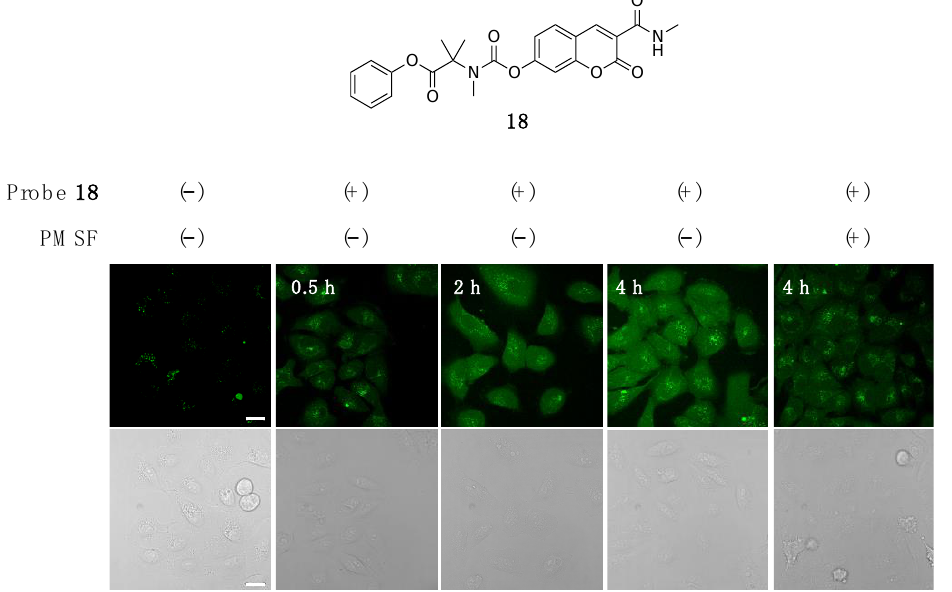
Figure 5. Fluorescence detection of intracellular esterase activity in living A549 cells using 18 . Cells were incubated with 18 at the indicated time at 37 °C in the presence or absence of PMSF. Conditions: ( 18 ) = 10 μM, (PMSF) = 500 μM, HBS buffer, λ ex = 405 nm. Scale bar: 20 μm.